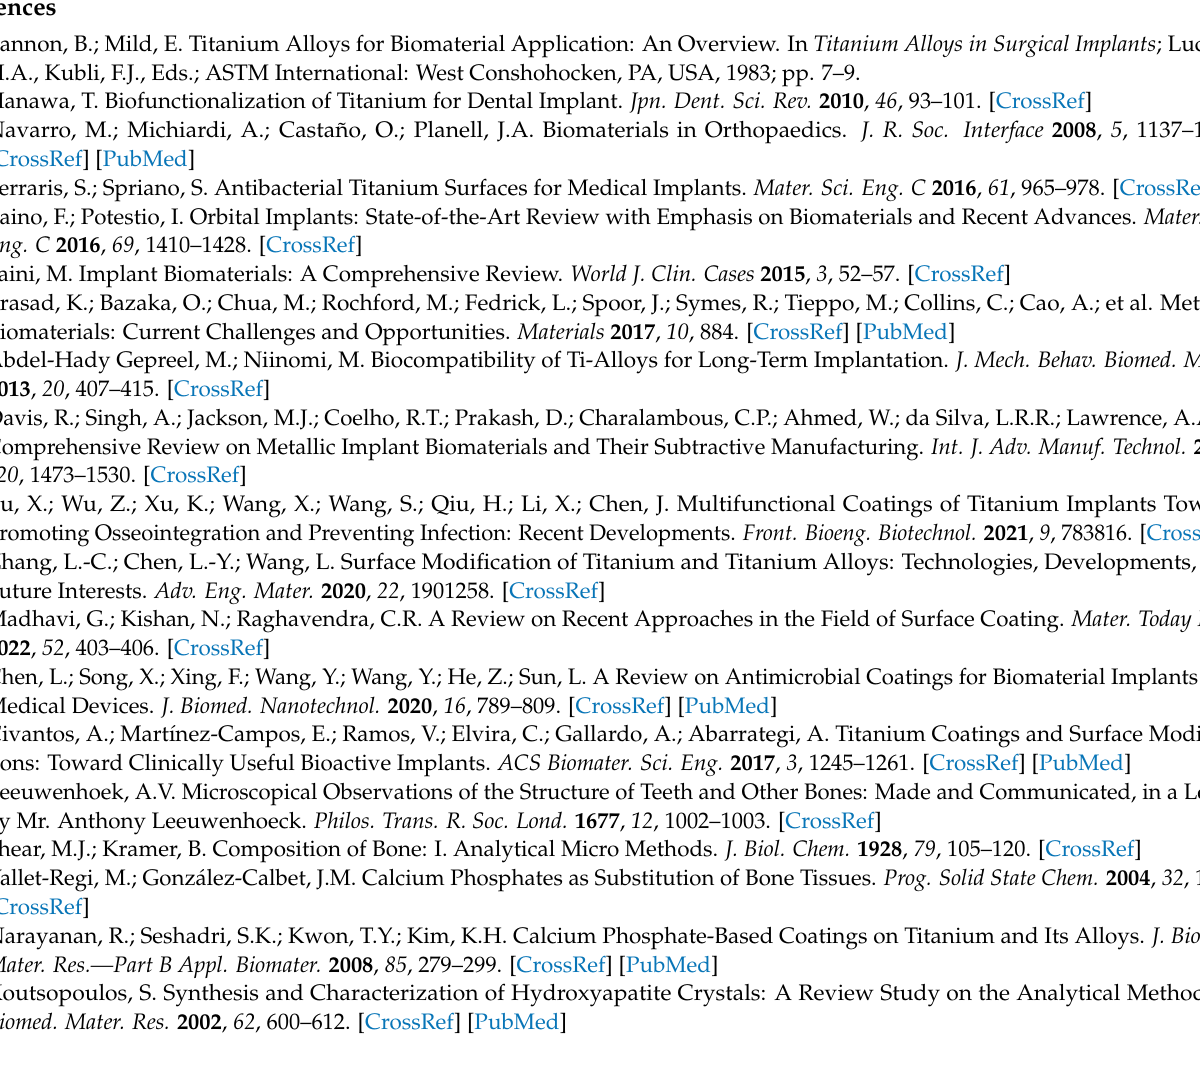
Figure 1; Figure S2: Original SEM images found in Figure 2; Figure S3: Original SEM images found in Figure 3; Figure S4: Original SEM images found in Figure